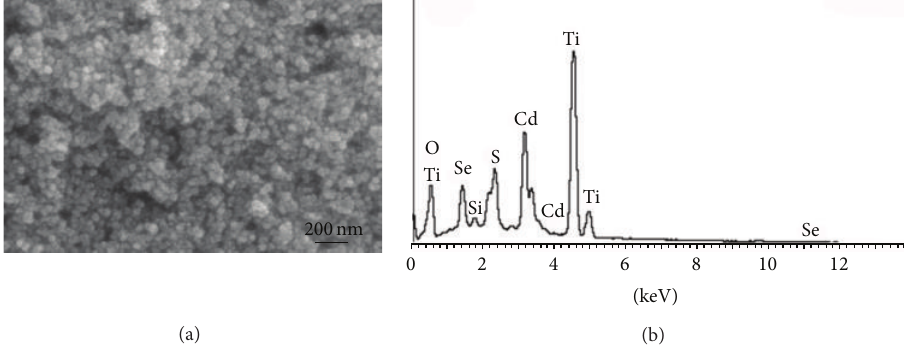
Figure 3: SEM image of photoanode and corresponding EDS energy spectrum diagram: (a) SEM image and (b) EDS energy spectrum.